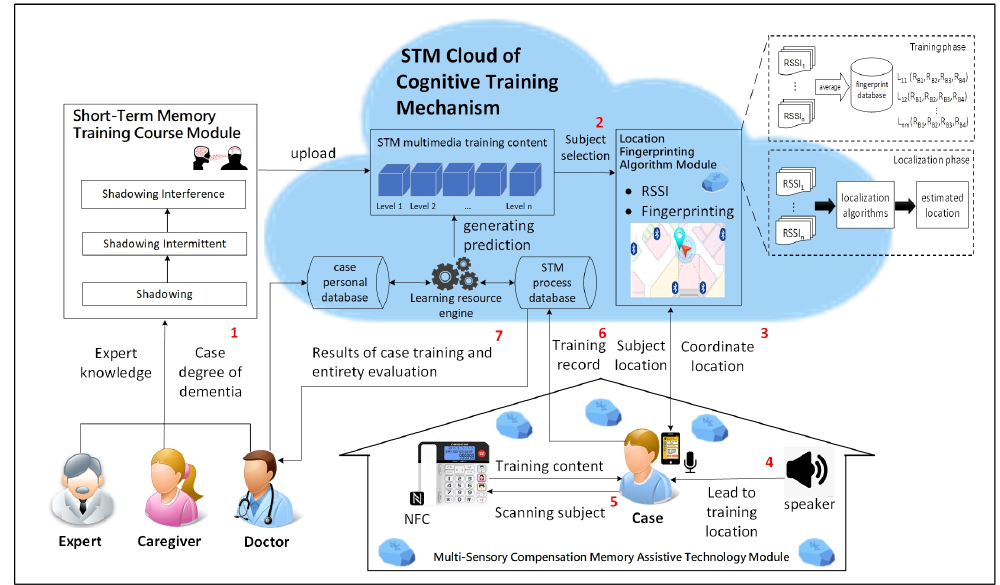
Figure 5. Context diagram of the digital short-term memory cognitive training system. NFC: the near-field